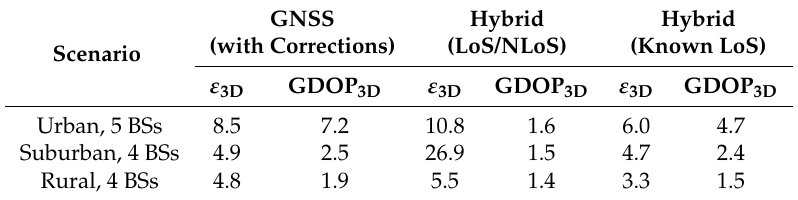
Table 4. 3D position error (in meters) and GDOP on the 95% of the cases for the GNSS positioning with differential or precise corrections and the hybrid GNSS and cmWave ToA positioning with and without LoS